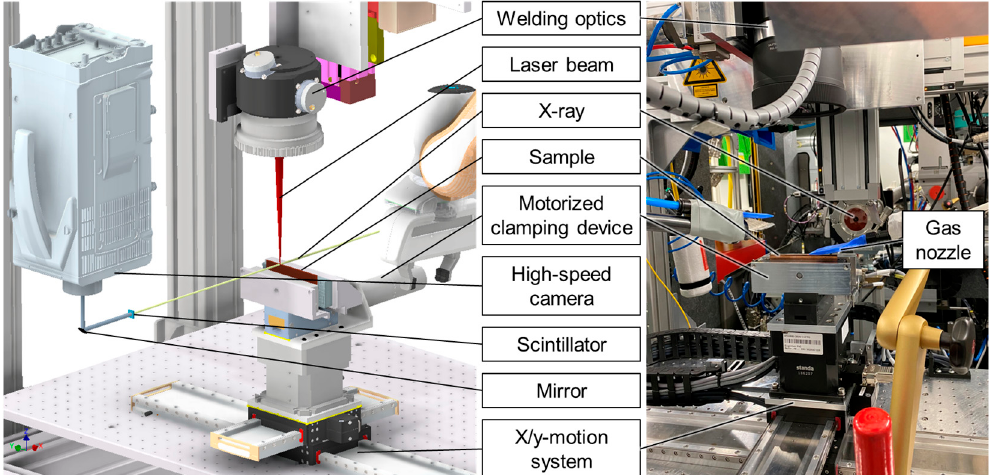
Figure 2. Experimental setup for phase contrast observation of laser welding; left: CAD-model, scintillator distance not to scale ( left ); real setup ( right ).